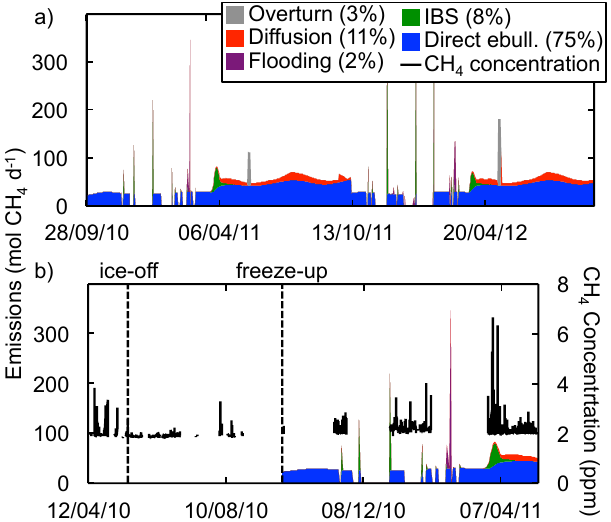
Figure 11. (a) Modeled daily CH 4 emissions to the atmosphere by each of the five mechanisms discussed in Sect. 3.2 in the baseline version of the model. Percentages in the legend denote the fraction of total annual emissions from each emissions mode. (b) Measured atmospheric CH 4 concentrations over Goldstream Lake shown with modeled emissions during a portion of the study period. In 2011 ice- off occurred on 15 May, after the period